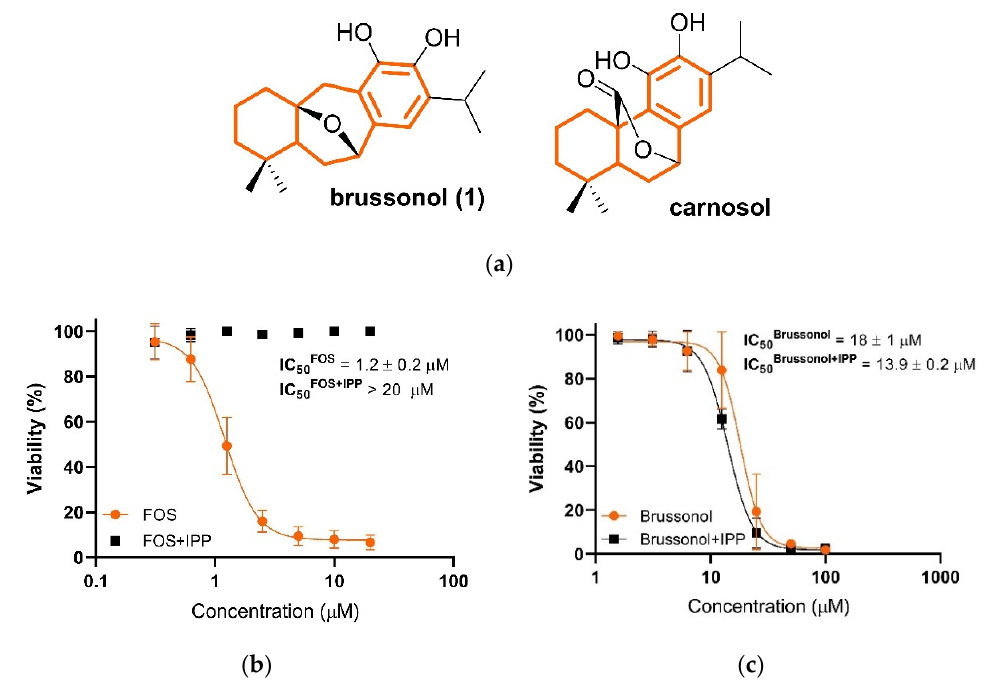
Figure 7. Chemical “rescue” assay to evaluate the action of brussonol ( 1 ) in the metabolism of isoprenoids ( a ) Molecular structures of carnosol and brussonol [35]. ( b ) Concentration–response curves for fosmidomycin (FOS, positive control) against P. falciparum 3D7 strain with and without the supplementation of IPP. ( c ) Concentration–response curves for brussonol against P. falciparum 3D7 strain with and without supplementation of IPP ( n ≥ 2, mean IC 50 ± SD).